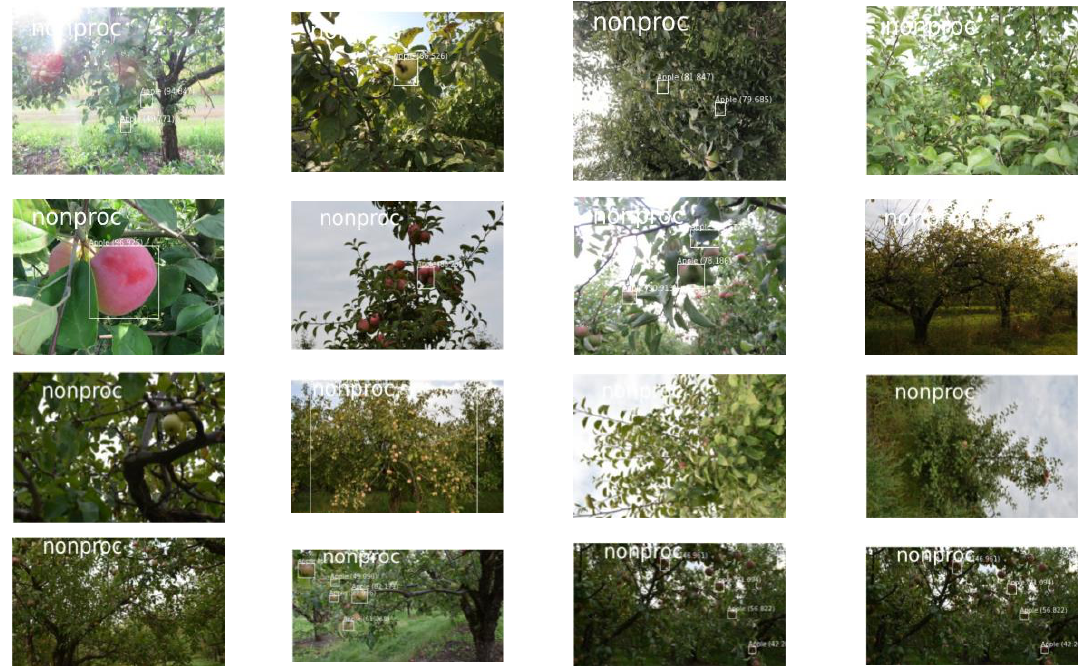
Figure 2. Examples of apple detection results by using You Look Only Once (YOLOv3) without pre- and post-processing. Table 1. Quality metrics for apple detection by standard YOLOv3 without pre- and post-processing.